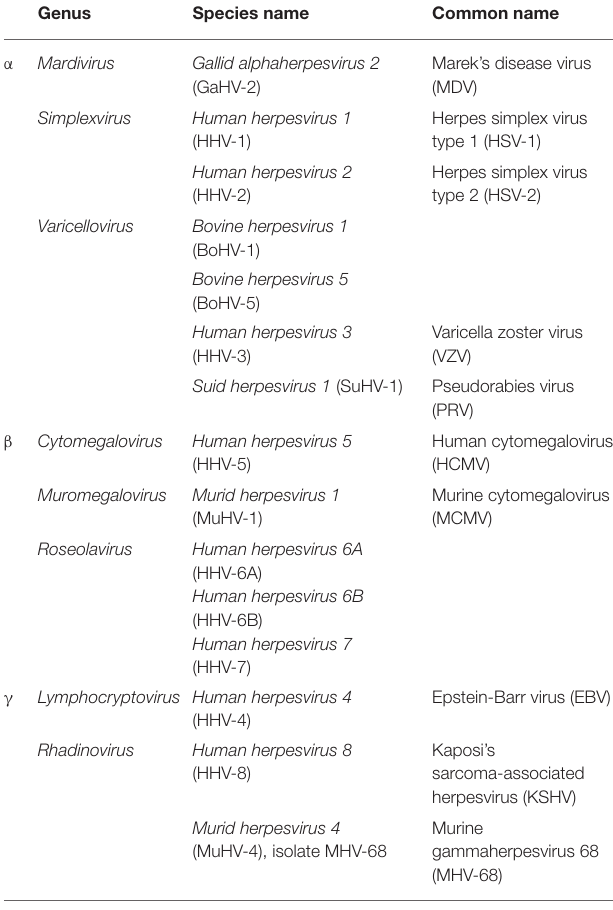
TABLE 1 | Taxonomic classifications of select members of the Herpesviridae